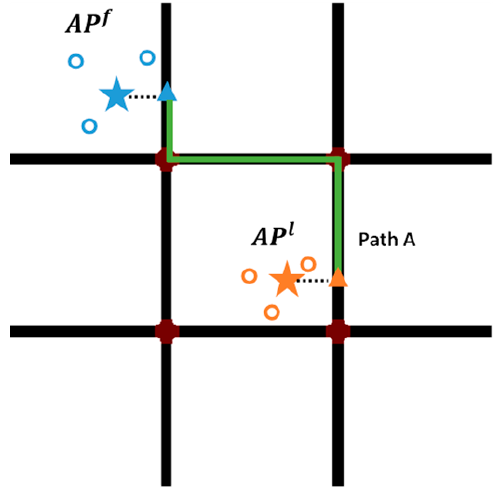
Figure 6. The orange anchor point is matched to the road network, and a path is reconstructed.